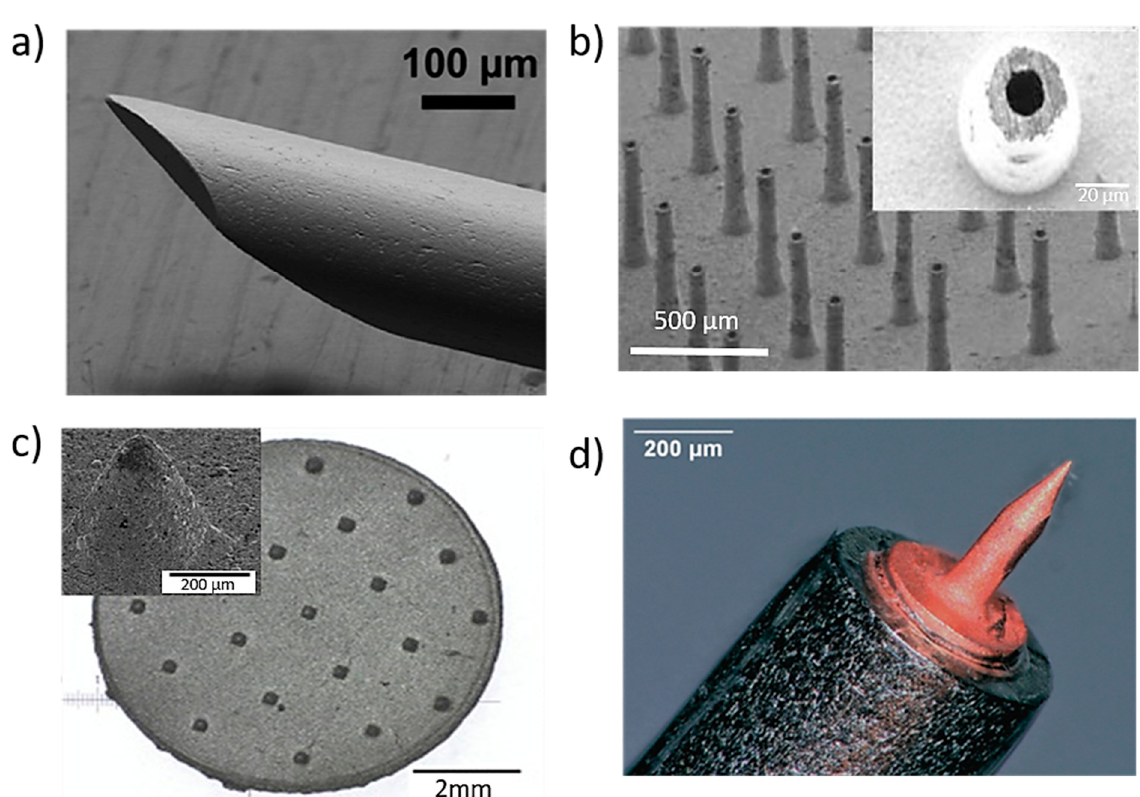
Figure 3. ( a ) Stainless steel MNs for blood extraction with outer diameter 210 mm and inner diameter 115 mm. Reprinted with permission from Ref. [84]. 2001, Royal Society of Chemistry. ( b ) titanium hollow microneedle array used for interstitial fluids sampling with height of 400 µ m and in wall thickness 20 µ m [87]; ( c ) porous 316 L stainless steel patches with 21 microneedles with a tip radius of 38 µ m aiming to be used in biosensors. Reprinted with permission from Ref. [89] 2005, Elsevier Science &Technology Journals; and ( d ) cold coated additively manufactured copper needle (height = 430 µm and tip radius = 1.5 µm) aiming the inner ear application [93].